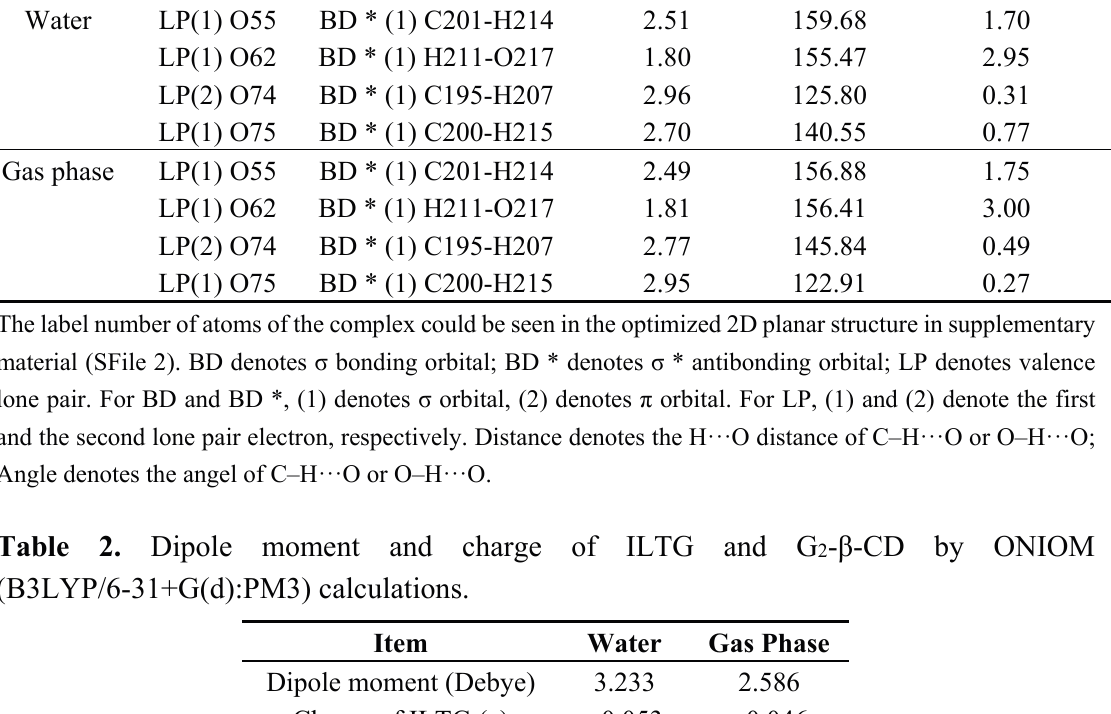
Figure 10. Binding conformations ILTG with G 2 - β -CD by ONIOM (B3LYP/6-31+G(d):PM3) calculations in ( A ) water and ( B ) gas phase. The dotted lines denote intermolecular hydrogen bonds. Table 1. Distance and angles and NBO donor-acceptor interaction energies E (2) for intermolecular hydrogen bonds in ILTG/G 2 - β -CD complexes by ONIOM (B3LYP/6-31+G(d):PM3) calculations. Medium